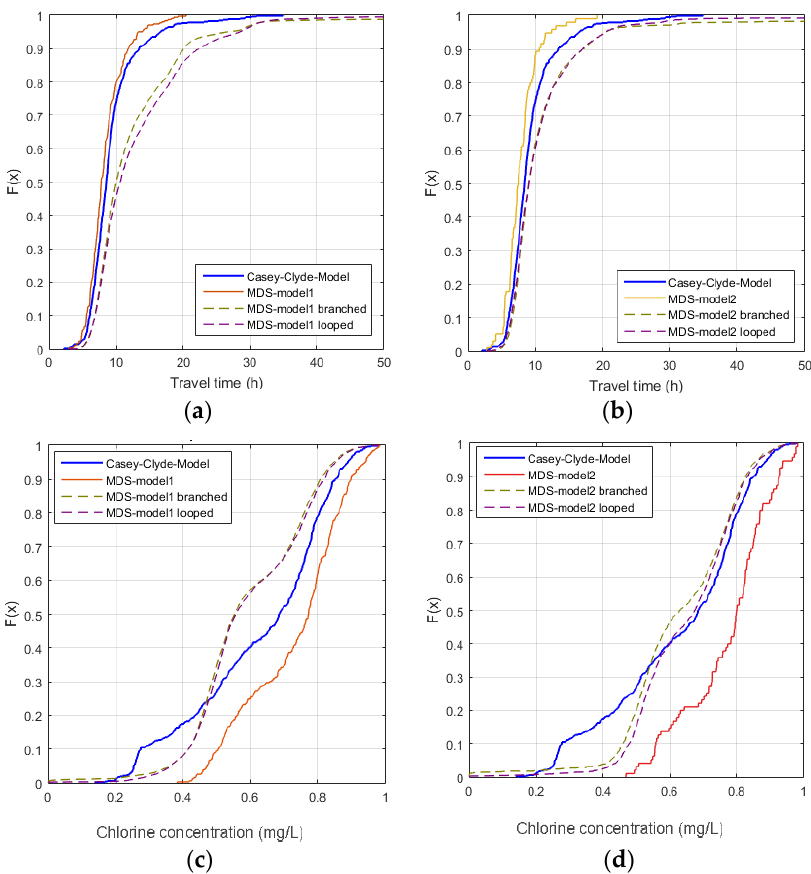
Figure 8. Cumulative distribution function (CDF) of the simulated node values for ( a ) travel time in the CCGA model in comparison to the MDS1 models (coarse, branched and looped refinements); ( b ) travel time in the CCGA model in comparison to the MDS2 models (coarse, branched and looped refinements); ( c ) chlorine concentrations in the CCGA model in comparison to the MDS1 models (coarse, branched and looped refinements); ( d ) chlorine concentration in the CCGA model in comparison to the MDS2 models (coarse, branched and looped refinements).